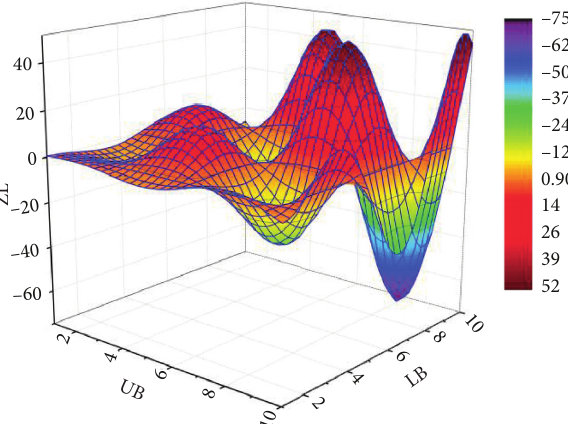
Figure 7: Comparison of approximate and optimal solutions for the two-stage vehicle paths under the session.